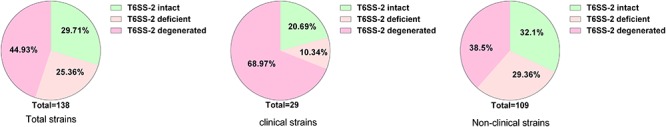
The distribution of T6SS-2 in 138 C. sakazakii strains, including clinical and non-clinical strains. The genome of each strain was compared to that of ATCC12868. Strains that lack the 13 essential core components of T6SS-2 are classified into the deficient group, while strains with the loss of several of vasK, tssH, hcp or other important genes partially, or entirely are defined as degenerated.